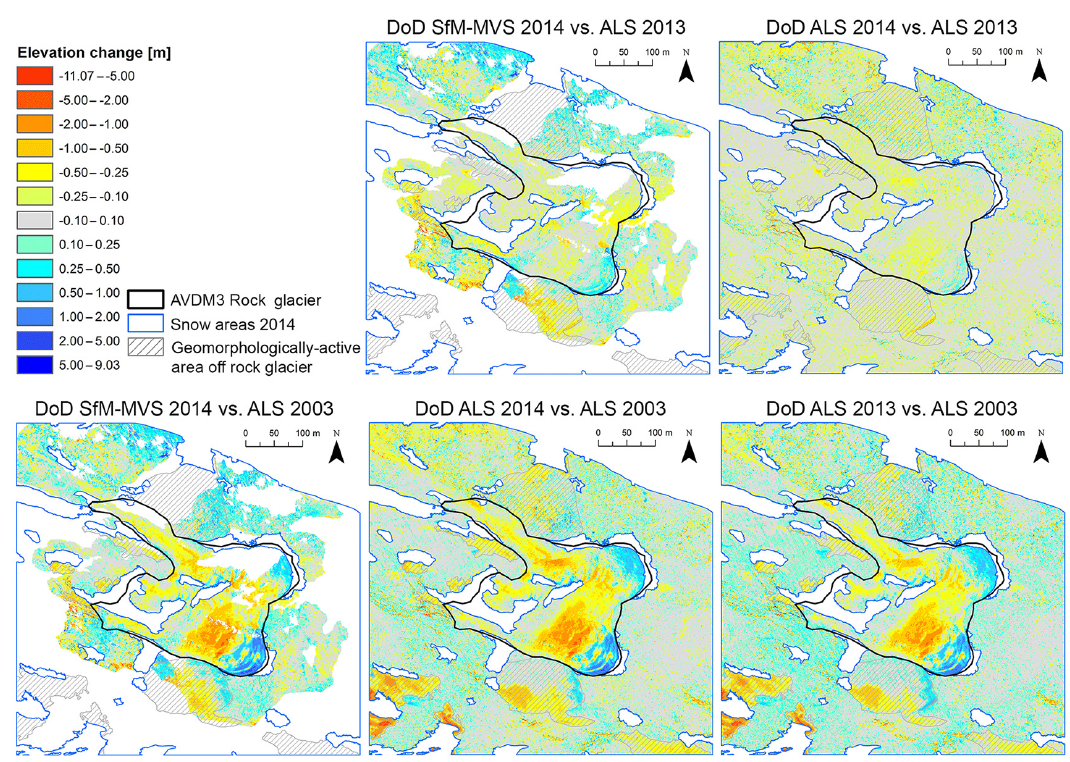
Figure 19. Spatial distribution of elevation changes from September 2014 to September 2013 and from September 2003 between the DEMs derived from SfM–MVS and ALS.